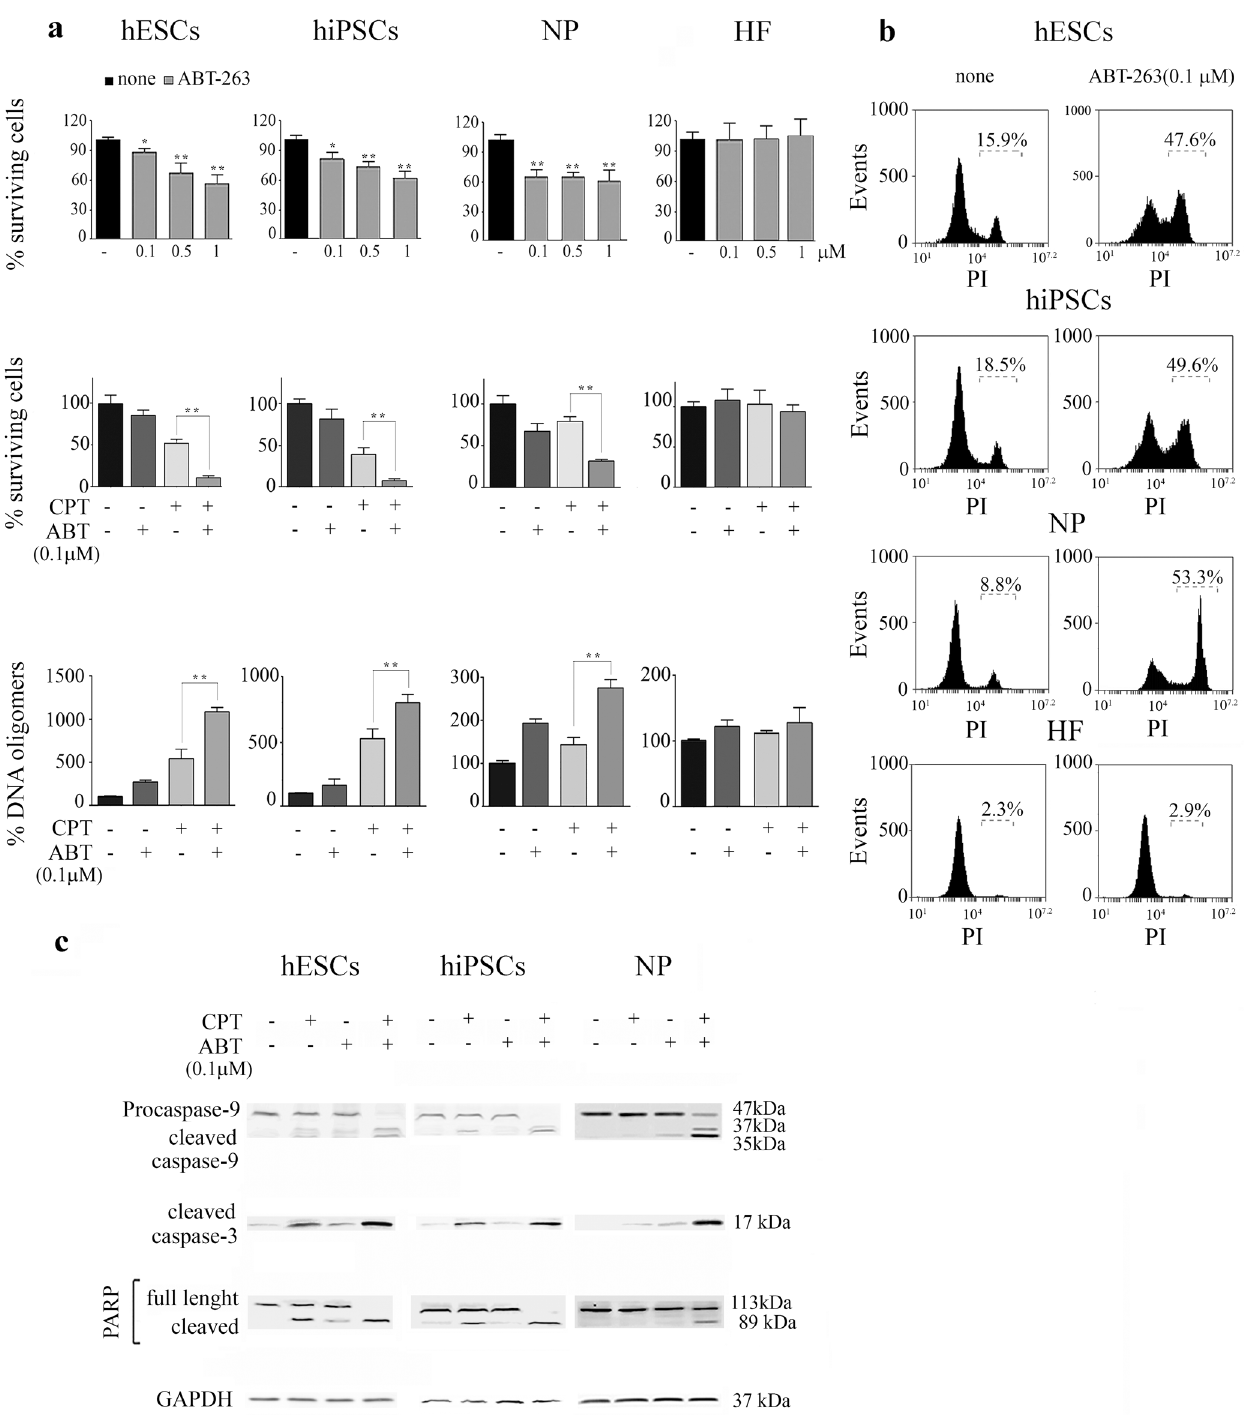
Fig 5. ABT-263 reduces cell viability and potentiates CPT-induced apoptosis in hESCs, hiPSCs and NP. (a) H9 hESCs, FN2.1 hiPSCs, hESCs- derived NP and HF were treated with increasing concentrations of ABT-263 (0.1 – 1 μ M) during 15h (top panel) or pre-treated with ABT-263 (0.1 μ M) for 1hour and then treated with CPT (1 μ M during 3h) (middle panel). Cell viability was measured by the XTT/PMS assay 15 h post ABT-263 (0.1 μ M) addition or 6 h after ABT-263 (0.1 μ M) and/or genotoxic removal. Results are presented as the percentage of the viability of untreated cells. Each bar represents the mean ± SEM of three independent experiments performed in quintuplicate. After 15 h of ABT-263 (0.1 μ M) addition or a withdrawal period of 3 h ABT-263 (0.1 μ M) and/or CPT-treated cells were harvested, and DNA oligomers were quantified by immunoassay (bottom panel). Results are presented as the percentage of DNA oligomers of untreated cells. Each bar represents the mean ± SEM of three independent experiments performed in triplicate. A paired Student's t test